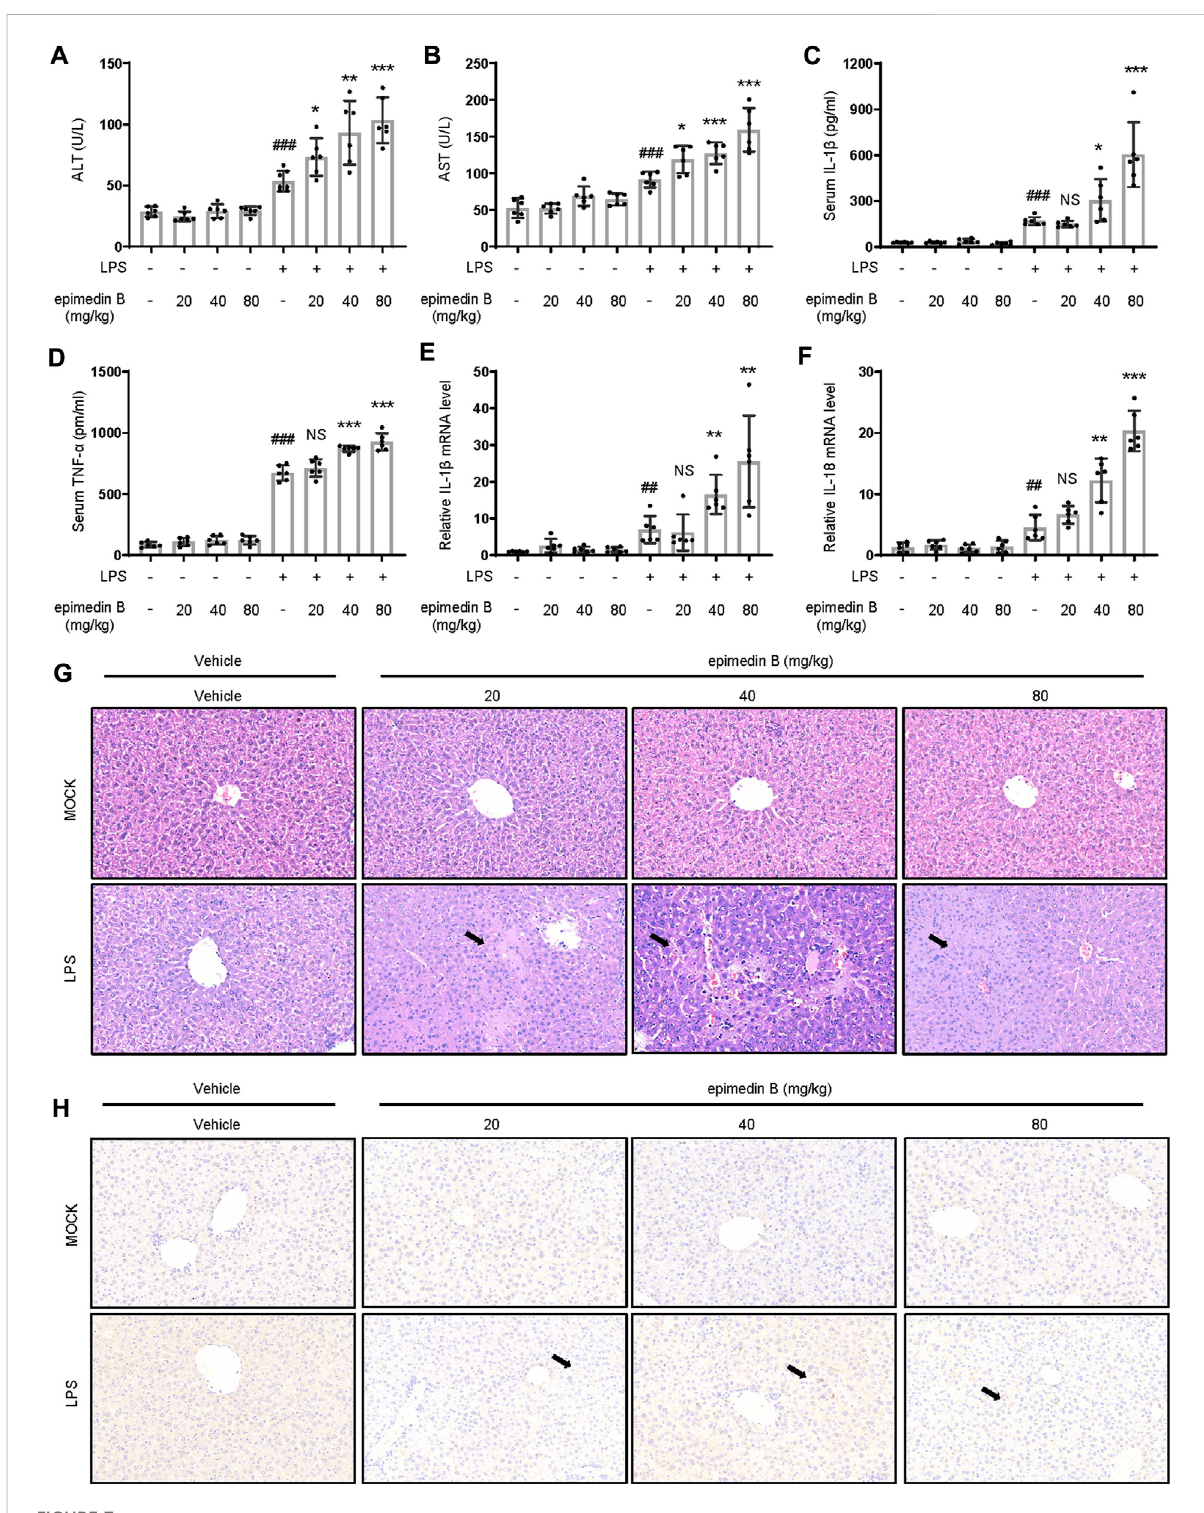
FIGURE 7 Epimedin B promotes early liver injury and in fl ammatory mediator production in vivo . (A – H) Female C57BL/6 mice (age: 6 – 8 weeks) subjected tostarvationfor24 hwereadministeredwith2 mg/kgoflipopolysaccharide(LPS)oritssalinevehicle via thetailvein(i.v.).Afteranobservationperiod of 2 h, various doses of epimedin B (20 mg/kg, 40 mg/kg, 80 mg/kg) or its vehicle were administered through intraperitoneal injection for 6 h (A,B) Serum levels of ALT (A) and AST (B) and (C,D) Serum levels of IL-1 β (C) and TNF- α (D) determined by ELISA. (E,F) PCR of IL-1 β (E) and IL-18 (F) mRNAlevels. (G,H) Representativemicrographs ofH&E staining (G) andF4/80staining (H) .Data arepresentedas themean ±SD.Thesigni fi cance of the differences was analyzed using unpaired Student ’ s t -test: # p < 0.05, ## p < 0.01, ### p < 0.001, * p < 0.05, ** p < 0.01, *** p < 0.001, NS: not signi fi